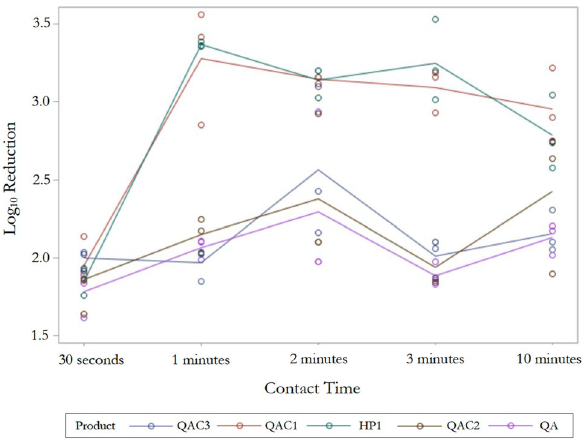
Figure 4. Interaction plot showing the relationship between contact time i.e., 30 s, one-min, two-min, three- min, and 10-min for each product (HP, QAC1, QAC2, QAC3, and QA) and mean log 10 reductions against C.